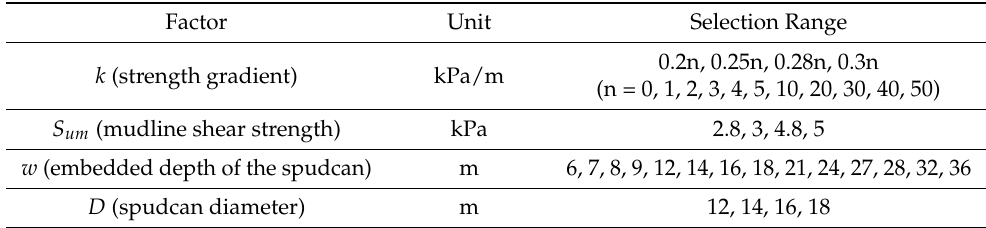
Table 3. Selection range of the parameter. Factor Unit Selection Range k (strength